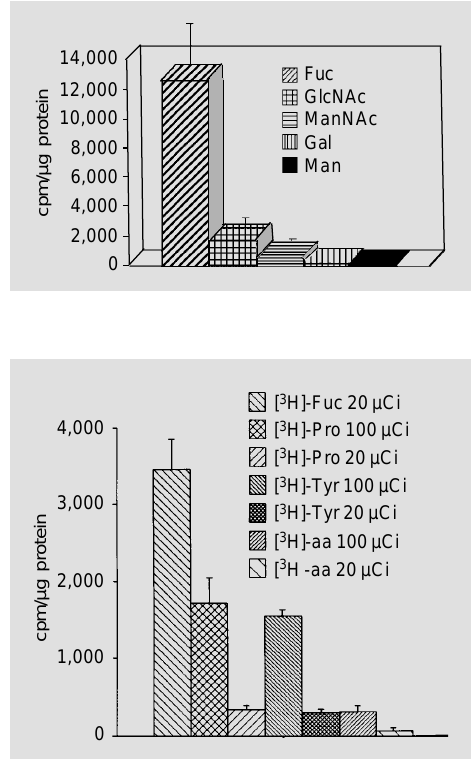
after intravitreal injection of 200 µCi of one of the following triti- ated sugars: fucose (Fuc), N- acetyl-glucosamine (GlcNAc), N- acetyl-mannosamine (ManNAc), galactose (Gal) or mannose (Man). Data are reported as means ± SD for 5 determina- tions.